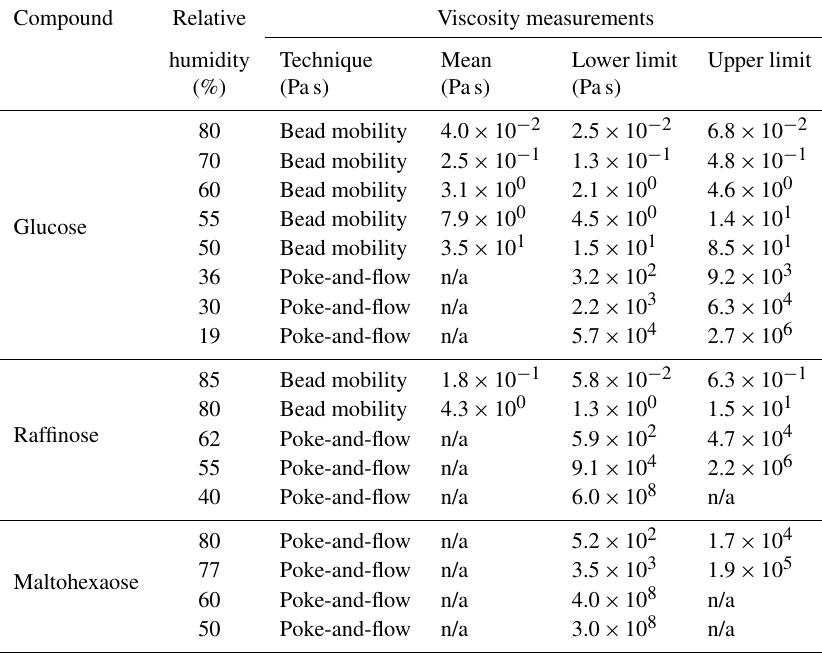
Table 5. Measured viscosities for the saccharide–water mixtures studied here. For experiments using the bead mobility technique, the mean is reported along with lower and upper limits, which correspond to an uncertainty of 2 σ . For experiments using the poke-and-flow technique, lower and upper limits of viscosity are reported, taking account of the 95% confidence limits of the simulated lower and upper limits of viscosity for the group of particles studied at each RH. Mean viscosities are not calculated using the poke-and-flow technique, and hence are represented as n/a in the